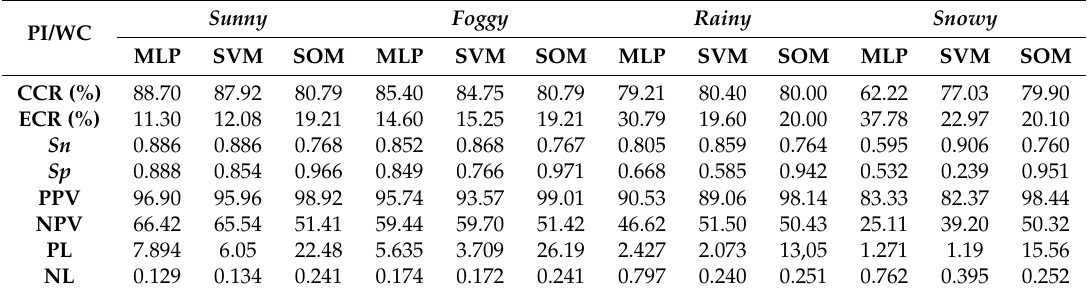
Table 4. Comparative study of artificial intelligence-based methods under different weather conditions. PI/WC